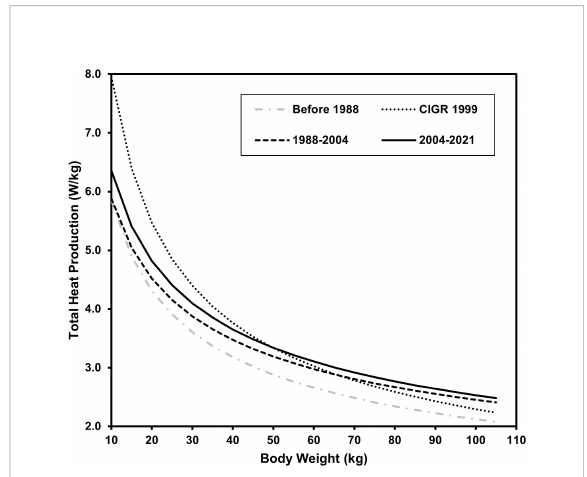
FIGURE 1 Swine heat production data for a BW range between 12.5 and 106 kg from 19 independent studies from 2004 through 2020. Parameters estimates of the regression equation were signi fi cantly different from 0 (P< 0.01).